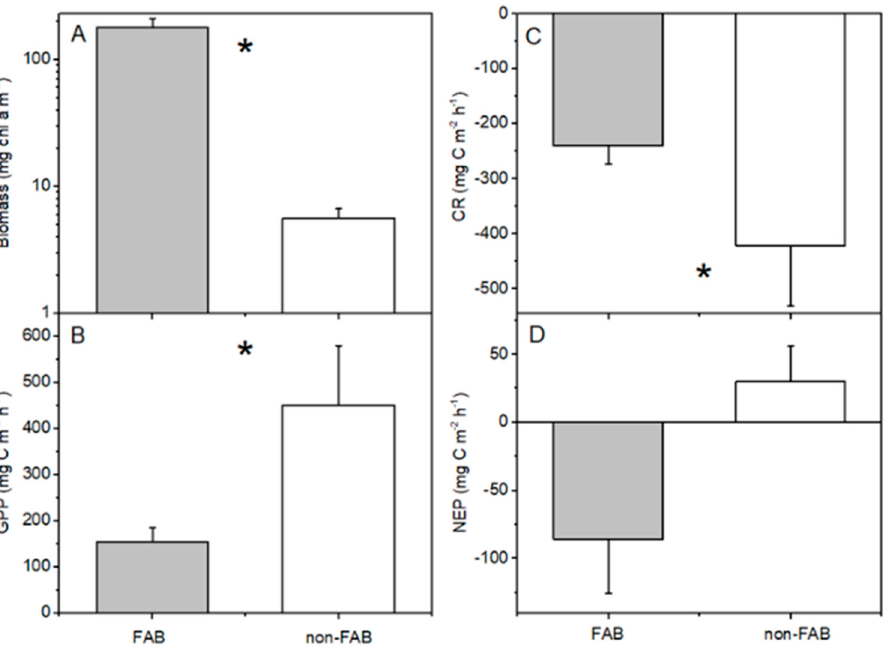
Figure 4. ( A ) Periphyton biomass, ( B ) gross primary production (GPP), ( C ) community respiration (CR), and ( D ) net ecosystem production (NEP) at FAB (filamentous algae blooms) and non-FAB sites in Bear Lake (June, July, October for FAB, n = 16; just July/October for non-FAB, n = 7, +standard error). Asterisks indicate significant differences between FAB and non-FAB values ( t -tests, p < 0.05).